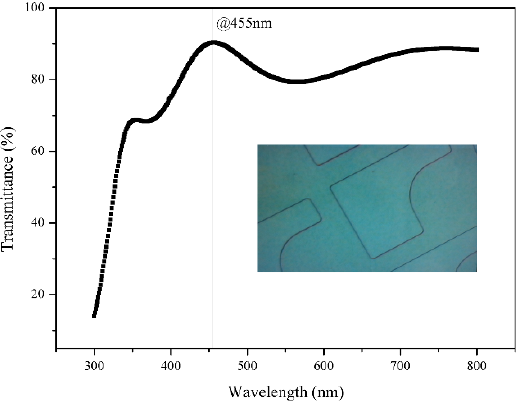
Figure 8. Transmittance of the ITO film and the etched patterns of the ITO